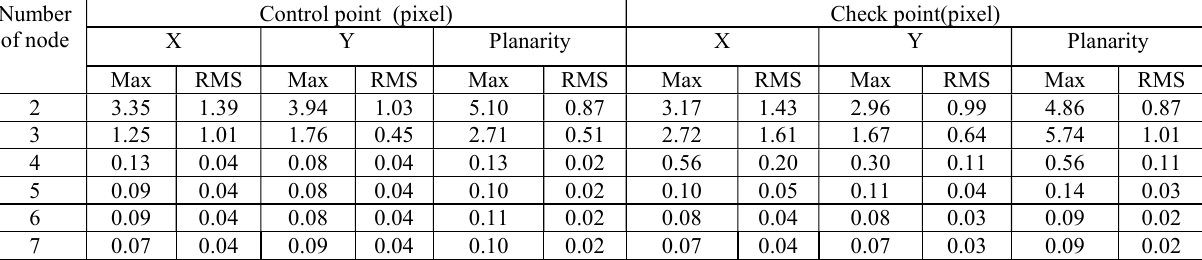
Table 2. BP neural network imagery geometrical model accuracy of dataset 1